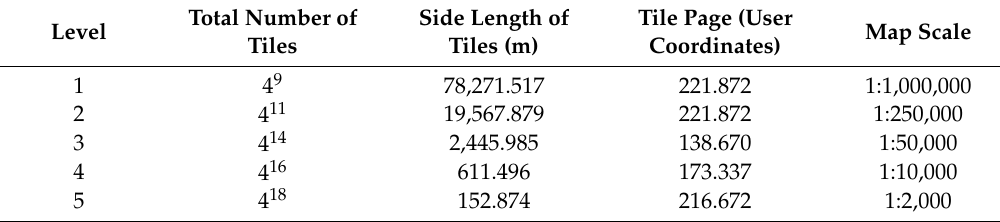
Table 2. PDF tile map pyramid rule list.